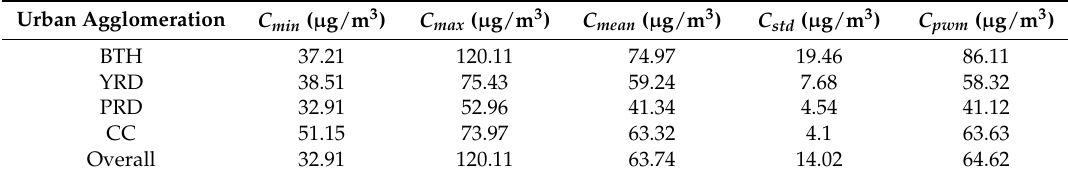
Figure 1. The air quality was relatively good in Zhangjiakou, Chengde, Qinhuangdao, and the corresponding PM 2.5 concentration in these cities were 47.52 μ g/m 3 , 59.45 μ g/m 3 and 66.06 μ g/m 3 , respectively. The worst was Baoding with a concentration of 116.21 μ g/m 3 , followed by Shijiangzhuang of 108.51 μ g/m 3 . Table 1. Statistical information of the urban agglomerations. Table 1. Statistical information of the urban agglomerations.